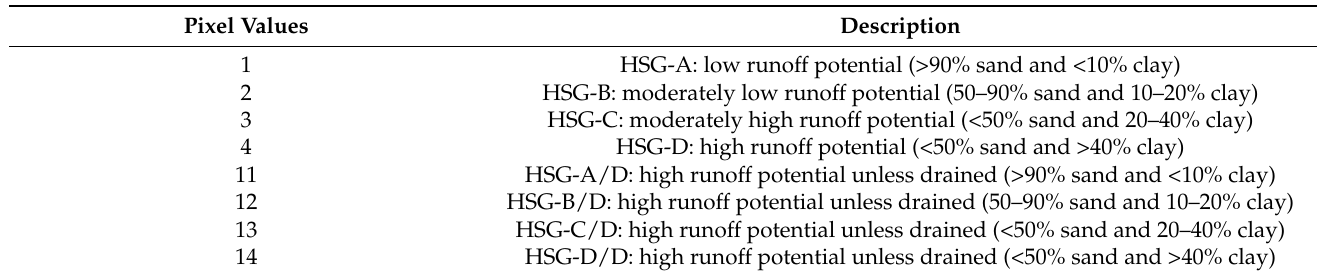
Table 3. The Global hydrologic soil group and its description.